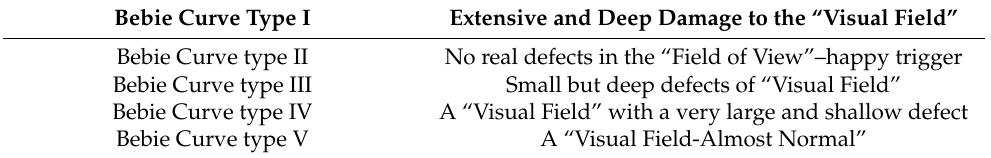
Table 1. Classification of the centralized defect of a “Visual Field” (VF) test result (Bebie Curve). Bebie Curve Type I Extensive and Deep Damage to the “Visual Field” Bebie Curve type II No real defects in the “Field of View”–happy trigger Bebie Curve type